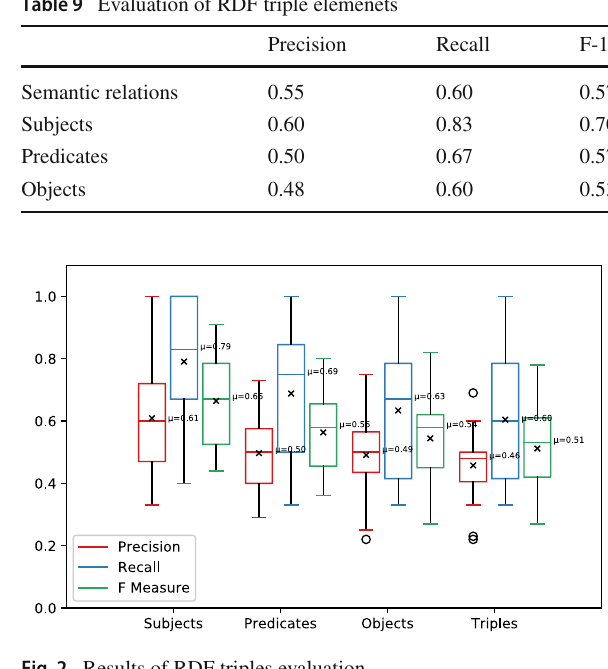
Fig. 2 Results of RDF triples